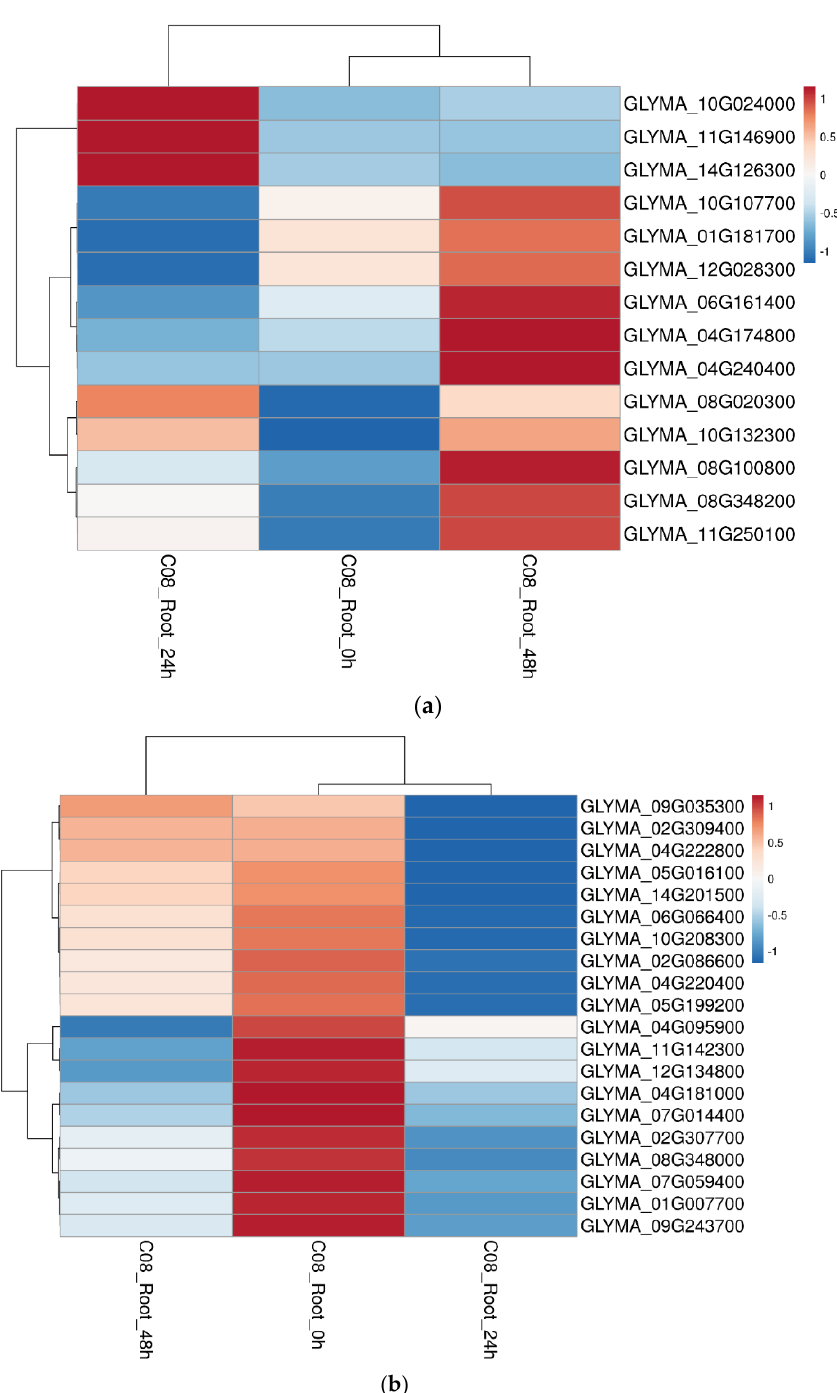
Figure 8. Gene expressions of up- and down-regulated membrane proteins in the root of soybean cultivar C08 upon salt treatment were consistent with the protein expression patterns. ( a ) Heat map of the gene expression levels of key up-regulated membrane proteins in the root based on RPKM values extracted from the published C08 transcriptomic data on the effects of 24 or 48 h of 150 mM NaCl treatment [20]. ( b ) Heat map of the gene expression levels of key down-regulated membrane proteins in the root based on RPKM values extracted from the published C08 salt treatment transcriptomic data [20]. Red bars represent up-regulated gene expressions and blue bars represent down-regulated gene expressions of the corresponding differentially expressed proteins from this study. White bars represent unchanged gene expression levels.